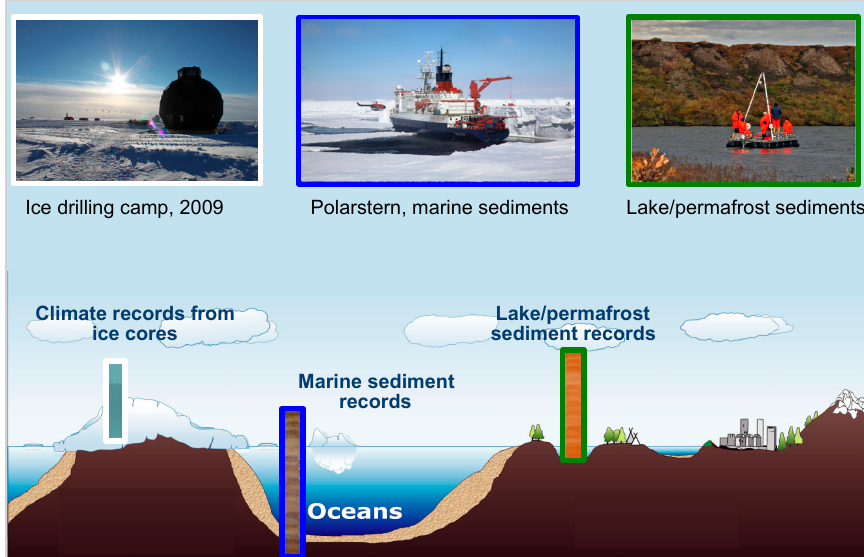
Figure 2. Example of paleoclimate archives revealing the climate of the past. Ice cores can be used to reconstruct the past atmospheric greenhouse gases in air bubbles and through the analysis of the ice composition the regional temperature. Sediment cores in the oceans and lakes provide large-scale patterns of ocean circulation and regional environmental changes (e.g., [4]).